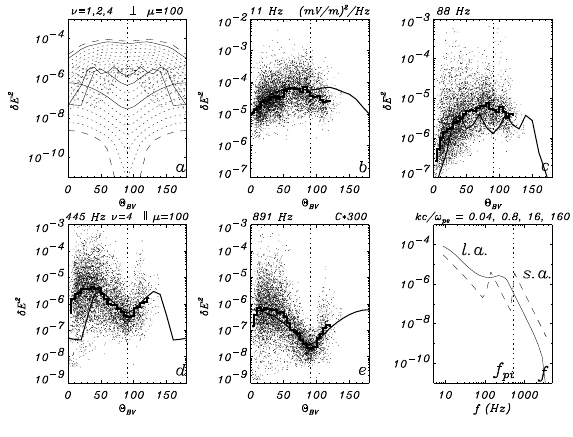
2 ( f, Θ BV ) k ) Figure10:Themodel δE (Eq.4)forthe ompositespe trum I 3 D ( of Fig.8b:theele tromagneti (cid:29)u tuations orrespondingtothesolidlineinFig. 8bsu(cid:27)erasimpleDopplershift;theele trostati (cid:29)u tuations orrespondingtothe Fig. 10. The model δE 2 (f,2 BV ) (Eq. 4) for the composite spec- dashedlineinFig.8bsu(cid:27)eraDopplershiftandhavethedispersionrelationof 2 (Θ BV ) attheSTAFF-SA theslow-iona ousti mode(Eq.9):a)themodel δE trum I 3 D ( k ) of Fig. 8b: the electromagnetic fluctuations corre- frequen ies(seethe aptionofFig.9a).Thefoursolidlines orrespondrespe tively to f =11Hz,88Hz,445Hzand891Hz;arbitraryordinates;b)themodelat sponding to the solid line in Fig. 8b suffer a simple Doppler shift; 11Hz(solidline)(seethe aptionofFig.9b); )themodelandtheobservations at88Hz,d)at445Hz,e)at891Hz;f)themodelspe traforlargeandsmall Θ BV the electrostatic fluctuations corresponding to the dashed line in (seethe aptionofFig.9f).10 Fig. 8b suffer a Doppler shift and have the dispersion relation of the slow-ion acoustic mode (Eq. 9): (a) the model δE 2 (2 BV ) at the STAFF-SA frequencies (see the caption of Fig. 9a). The four solid lines correspond, respectively, to f =11Hz, 88Hz, 445Hz and 891Hz; arbitrary ordinates; (b) the model at 11Hz (solid line) (see the caption of Fig. 9b); (c) the model and the observations at 88Hz, (d) at 445Hz, (e) at 891Hz; (f) the model spectra for large and small 2 BV (see the caption of Fig.